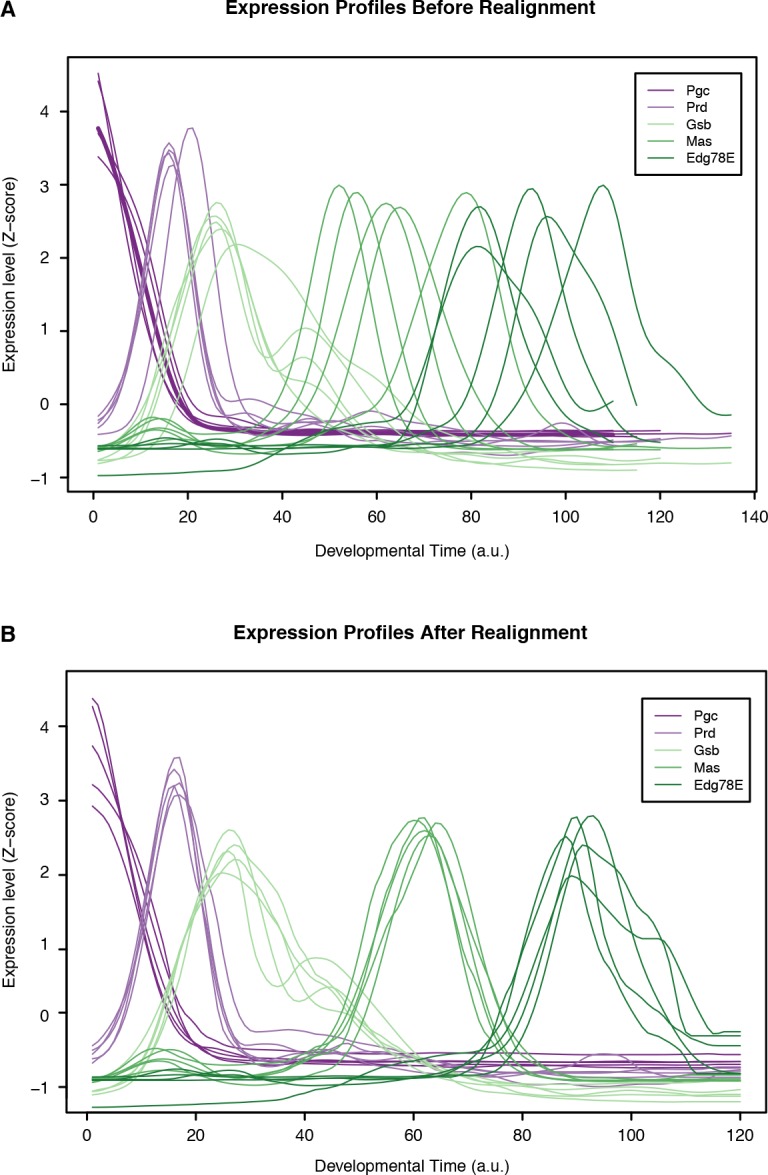
Time series alignment by time-warping of gene expression profiles.Global gene expression profiles from all species were aligned to the D. melanogaster time series as de- scribed in Materials and methods. This figure shows the expression profiles for well-characterized developmental regulators before (A) and after (B) alignment. The time scale corresponds to the absolute D. melanogaster developmental time (24 hr divided into 120 units by upsampling).